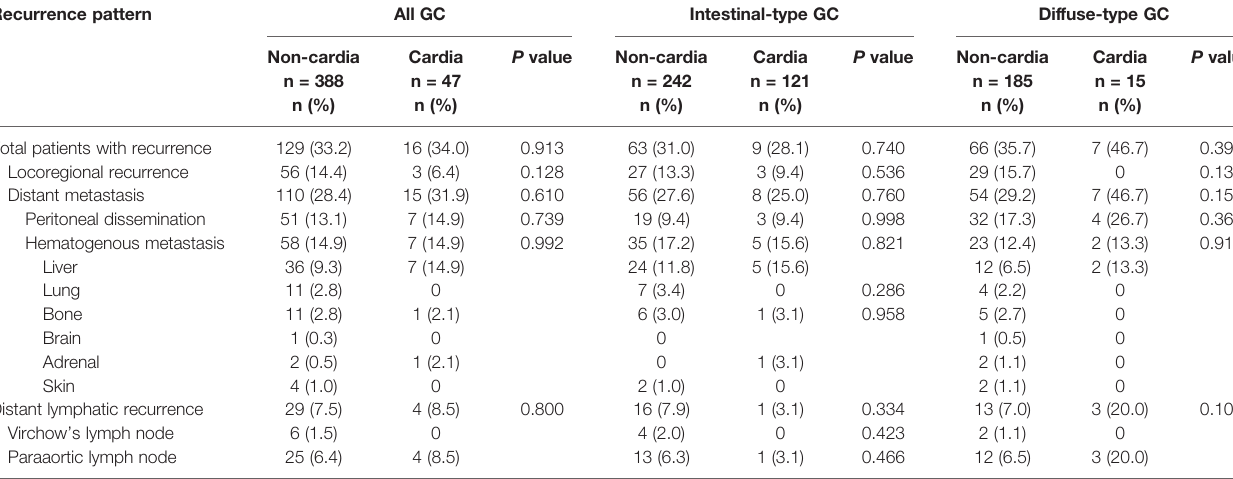
TABLE 3 | The initial recurrence pattern between cardia and non-cardia GC patients in intestinal-type and diffuse-type GC. Recurrence